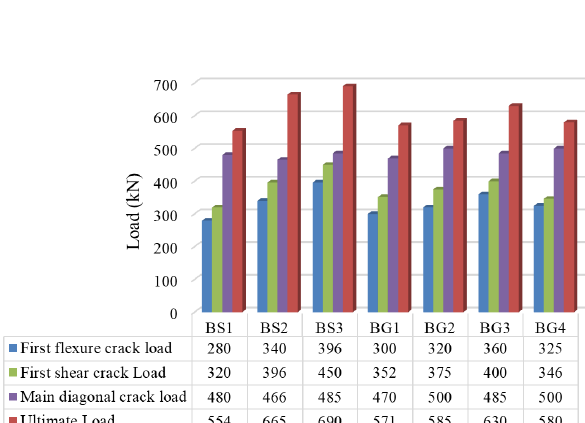
Figure 4: Crack development and mode of failure